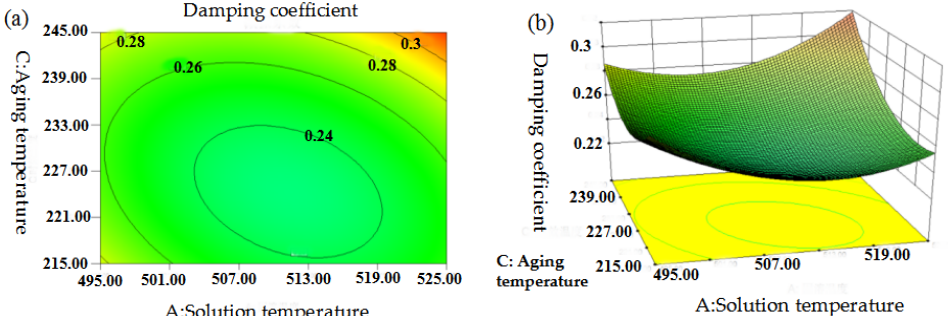
Figure 15. Interaction between ageing temperature and solution temperature versus the damping coefficient. ( a ) contour map; (b ) surface response map.